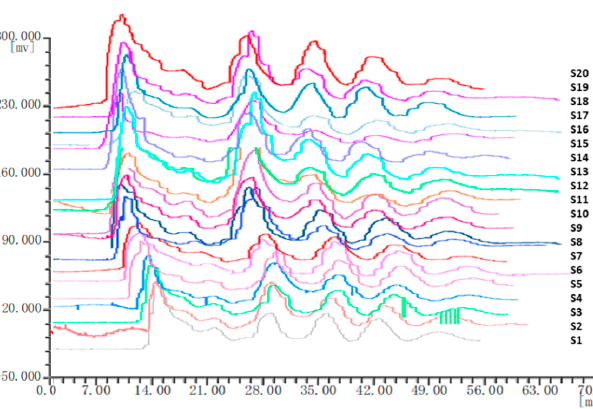
Figure 3. Twenty batches (S1–S20) of Psorslea corylifolia L. fingerprints. Molecules 2019 , 24 , x FOR PEER REVIEW